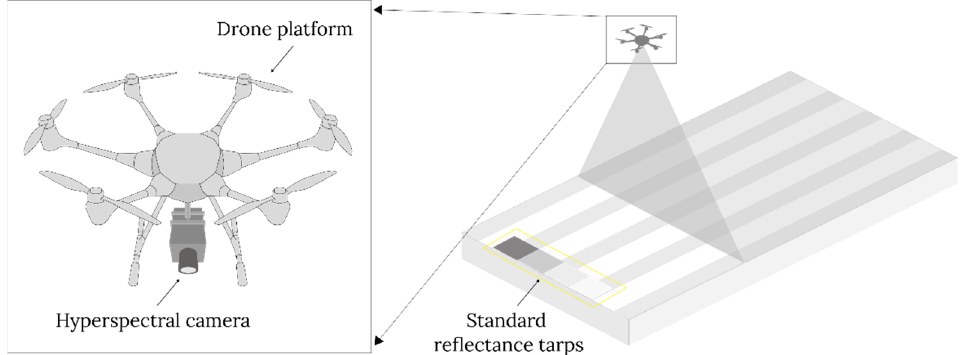
Figure 8. A typical UAV-based hyperspectral imaging system setup consists of a drone platform, a hyperspectral camera, and standard reflectance tarps. hyperspectral camera, and standard reflectance